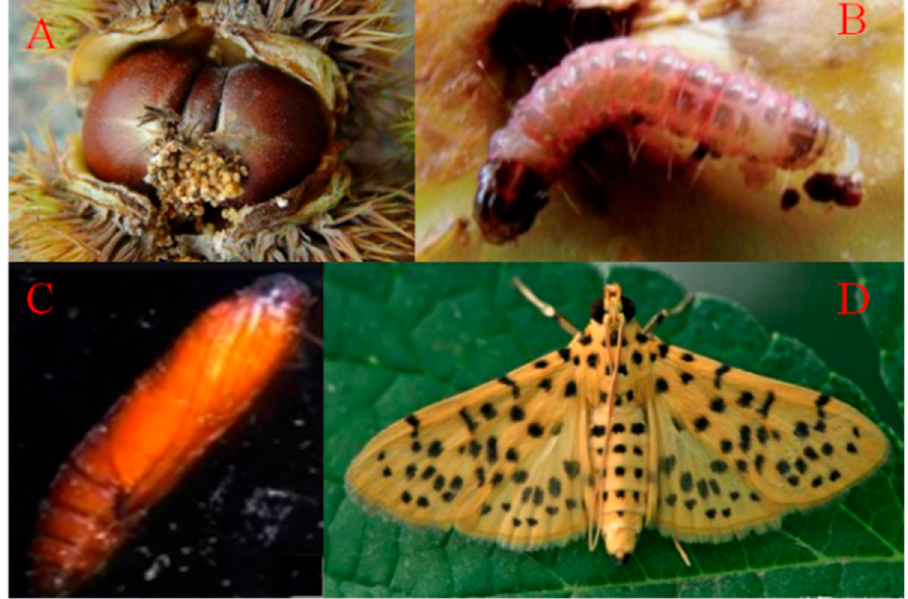
Figure 3. Dichocrocis punctiferalis GUENEE is the main insect pest of Chinese chestnut in Luotian County, Hubei Province, China. Chestnuts attacked by D. punctiferalis ( A ), and different stages of the life cycle of D. punctiferalis : larva ( B ), pupa ( C ), and adult ( D ). Photos were taken in a private orchard in Luotian County, Huanggang City, Hubei Province, China in 2021.